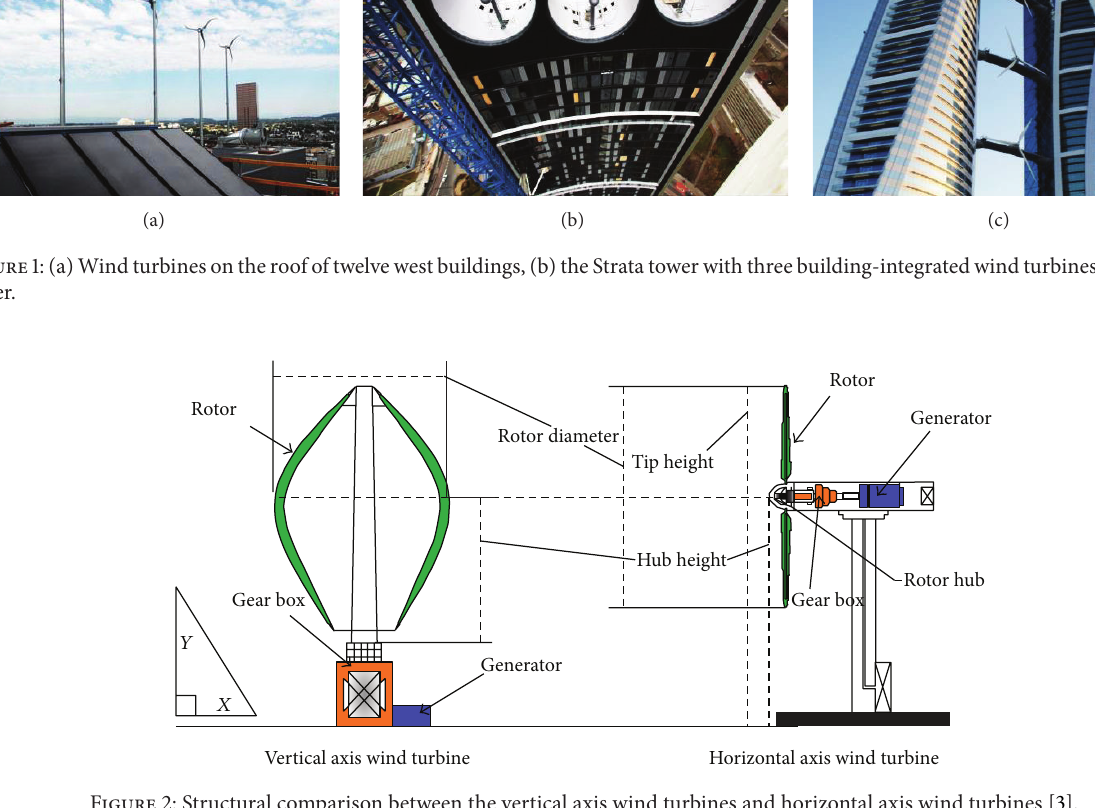
Figure 2: Structural comparison between the vertical axis wind turbines and horizontal axis wind turbines